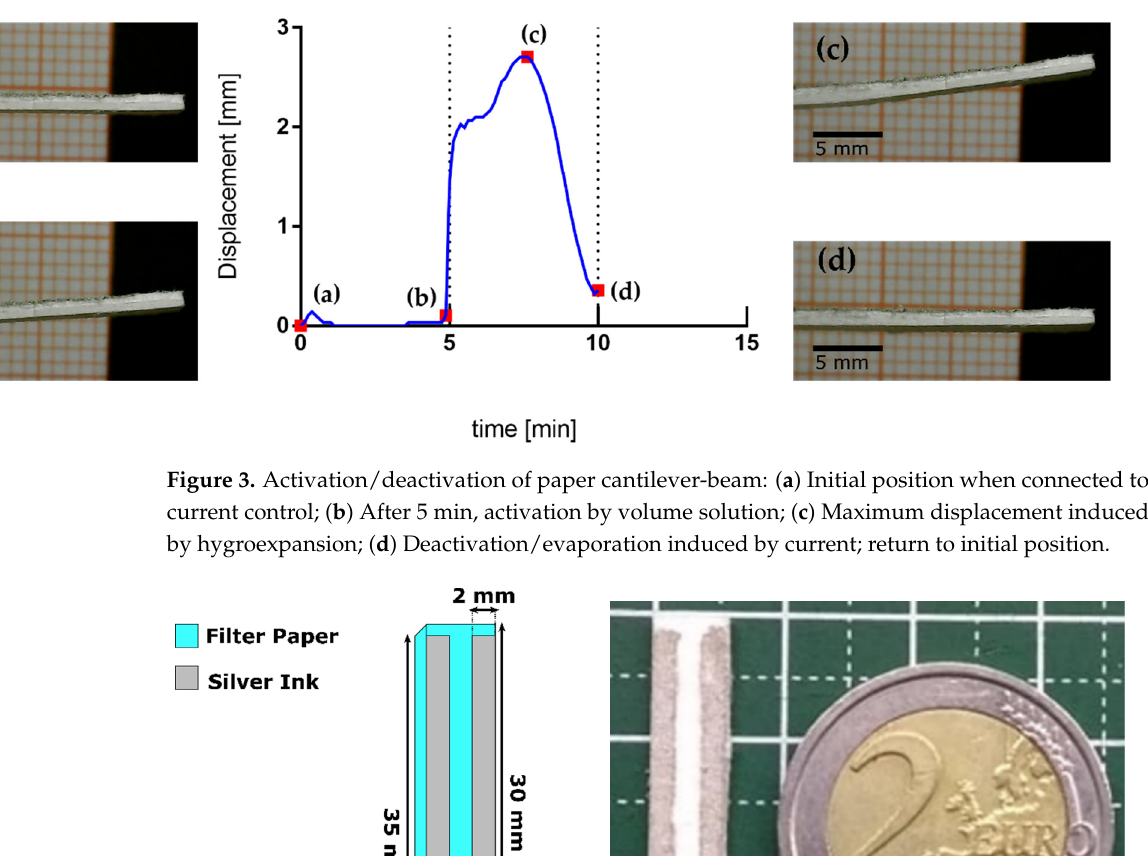
Figure 5. Experimental setup used for testing and to validate the proposed mini actuator com- posed by: ( A ) the holder, ( B ) the illumination system, ( C ) the handheld microscope, ( D ) the cur- rent control, and ( E ) the power supply.